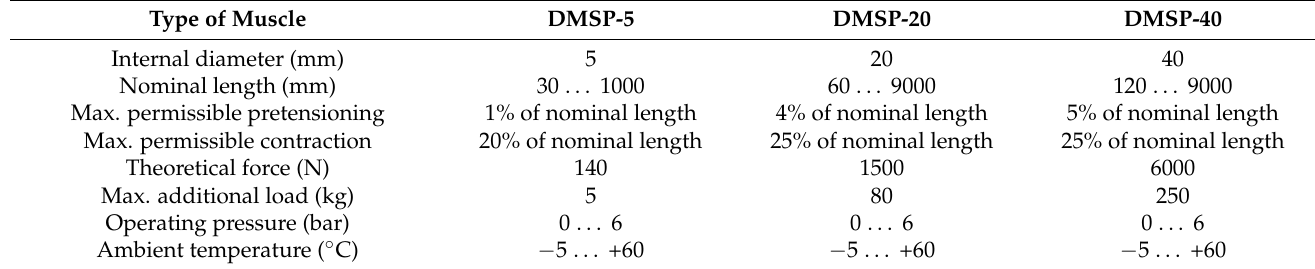
Figure 1. Fluidic muscles with press-fitted connections: ( a ) DMSP-40, ( b ) DMSP-20, and ( c ) DMSP-5 [55]. Table 3. Overview of the technical data of the selected DMSP muscles [55,56].